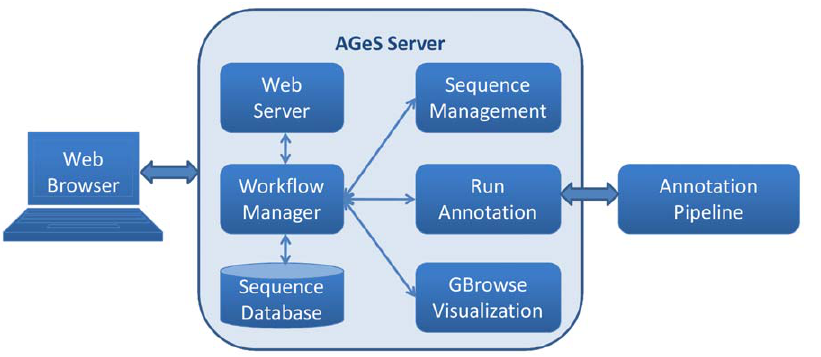
Figure 1. Annotation of microbial Genome Sequences (AGeS) system architecture. The Web server hosts the AGeS Web application and accepts user requests via standard Web browsers. The workflow manager handles user requests for sequence management, runs the annotation pipeline, and presents the annotation results via GBrowse visualization. The sequence database stores all sequence and job-related data.